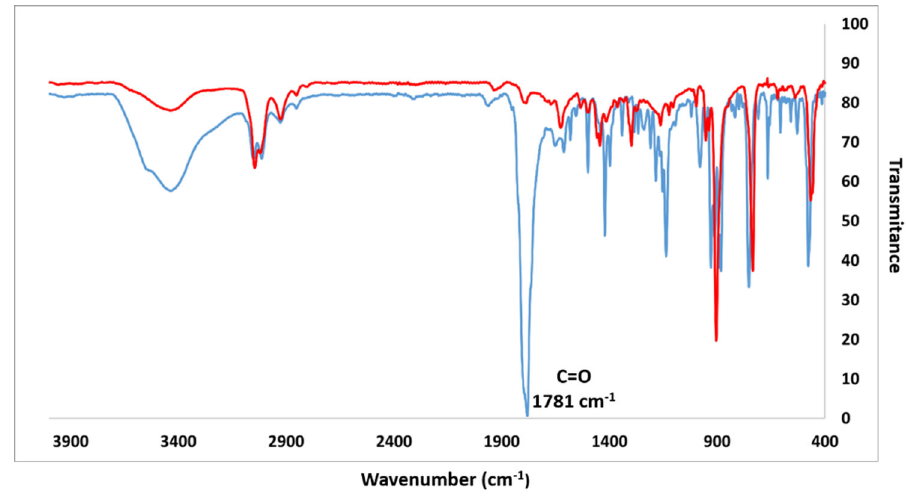
Fig. 6 FTIR spectra (KBr pellets) of a carbonylated precursor and of nonacene 1. The spectrum of the precursor 7b is in blue, with a strong CO peak at 1781 cm − 1 and that one of the resulting nonacene 1 is in red, after 1 min. heating at 350 °C in